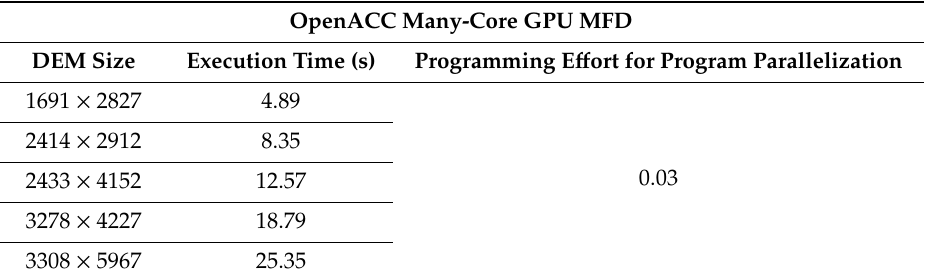
Table 4. Experimental results for OpenACC many-core GPU MFD.